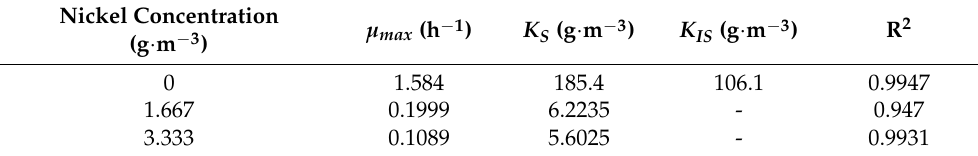
Table 2. Parameters of the equations for bacterial growth on phenol in the presence of nickel.